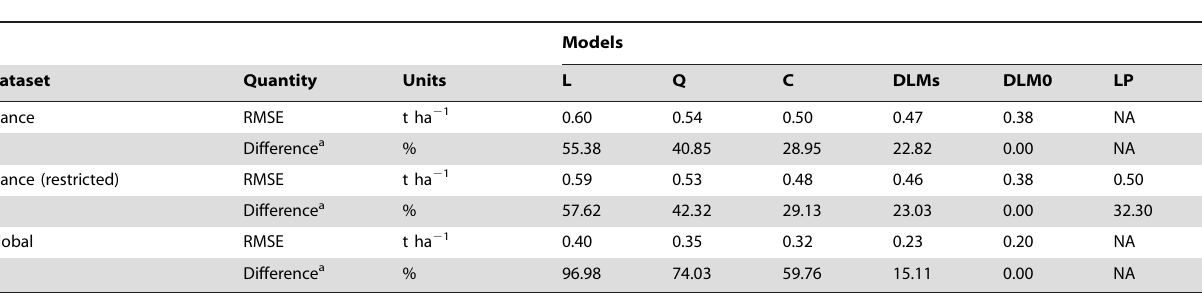
Table 1. Root mean square errors (RMSE) obtained with three different datasets for several statistical models: linear regression (L), quadratic regression (Q), cubic regression (C), dynamic linear models with and without trend (DLMs, DLM0), and linear-plus-plateau